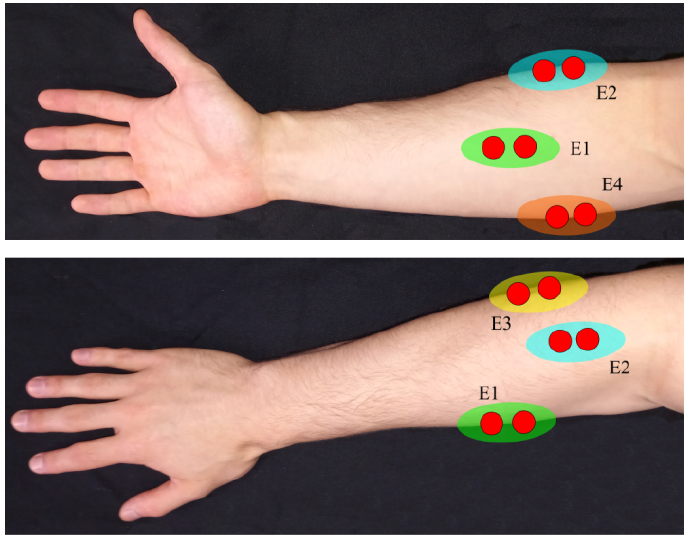
Figure 8. EMG electrode placement on hand muscles. E1 Flexor digitorum superficialis. E2 Extensor digitorum communis. E3 Flexor carpi ulnaris. E4 Flexor pollicis